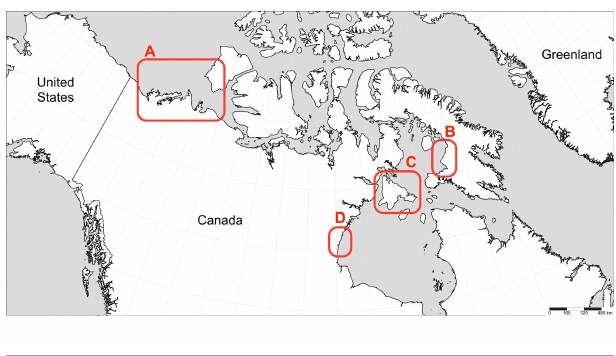
Fig. 1 . Canadian Arctic regions where digital aerial imagery of Lesser Snow Goose ( Chen caerulescens caerulescens ) breeding colonies was collected from 2009 to 2014: (A) Western Arctic, (B) Baffin Island, (C) Southampton Island, and (D) West Hudson